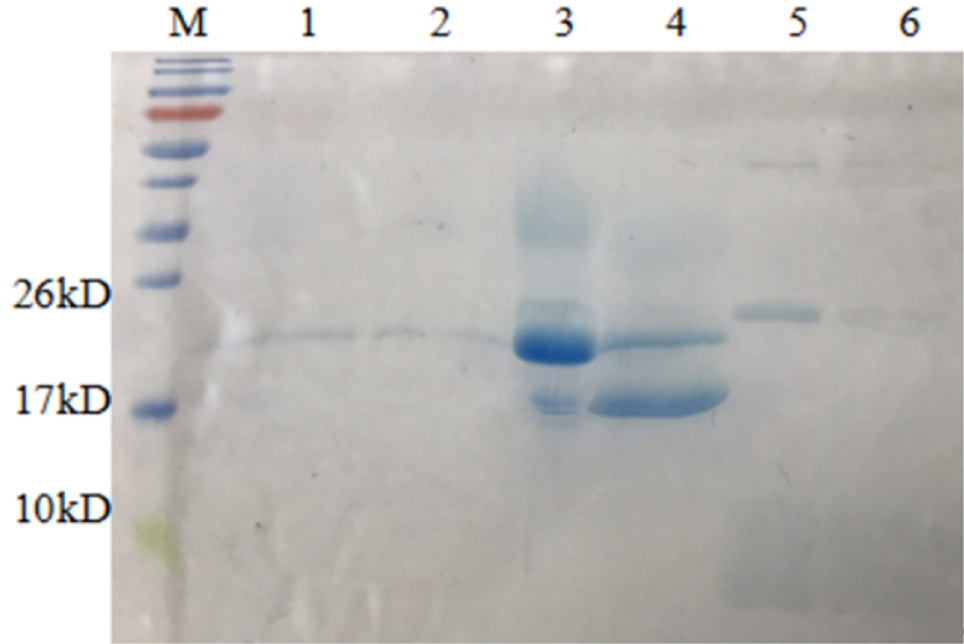
Figure 10. SDS-PAGE (12%) analysis of HRV 3C protease cleavage of AMP13. M, protein molecular weight marker. Lane 1, the supernatant from P. pastoris ; lane 2, the supernatant from P. pastoris heated to 80 °C for 30 min; lane 3, the nickel column before digestion; lane 4, the nickel column after digestion and elution; lane 5, the digestion supernatant; lane 6, HRV 3C Cleavage wash buffer.